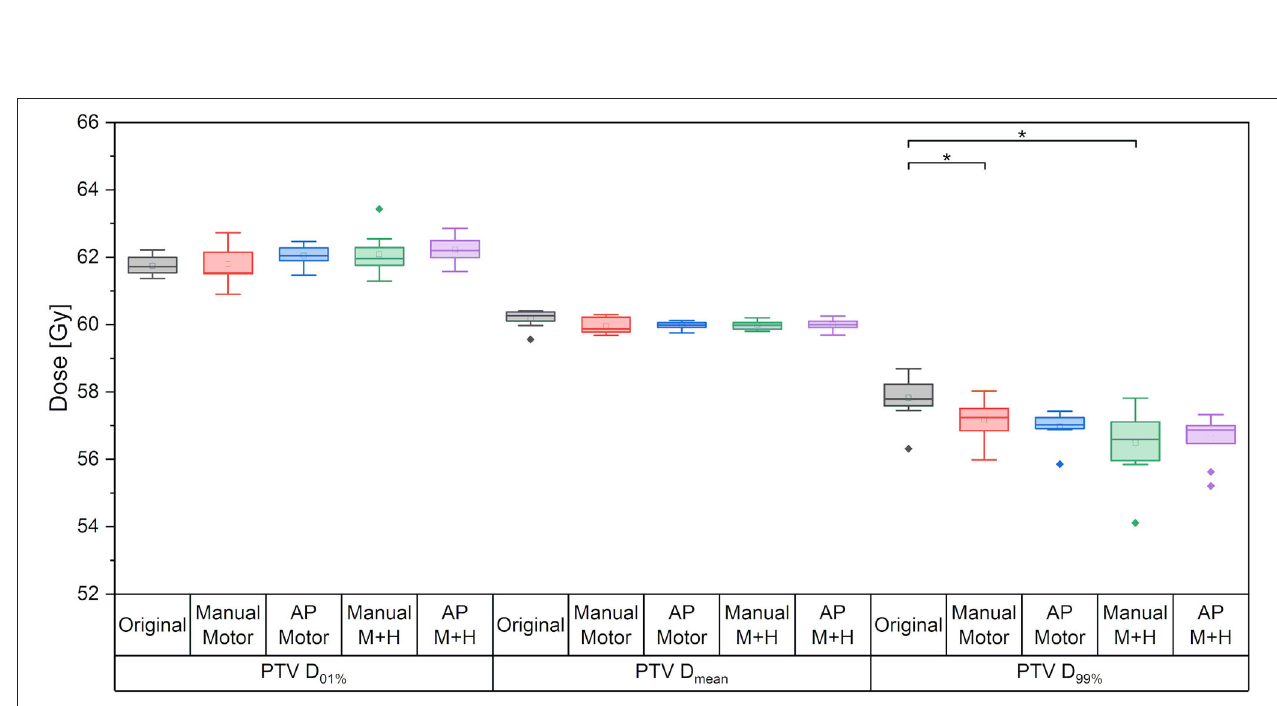
FIGURE 3 | Dose-volume histogram for the example patient in Figure 1 .